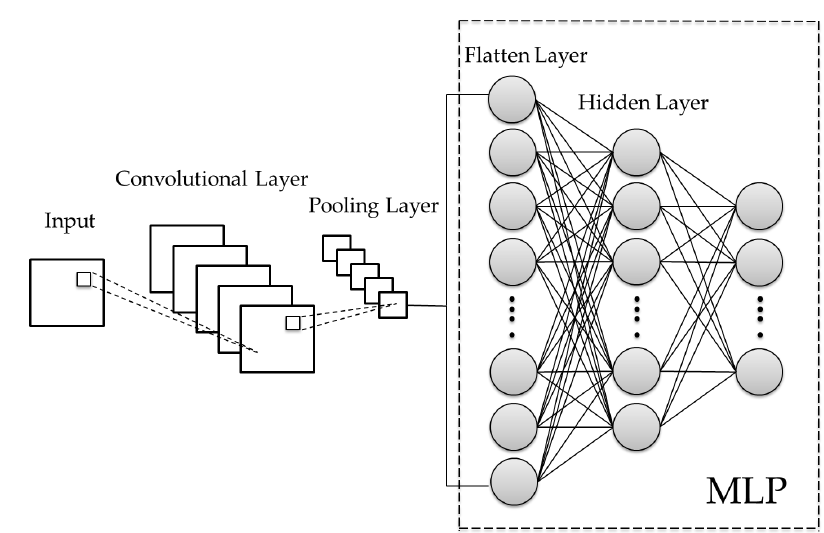
Figure 1. Convolutional neural network (CNN) architecture diagram.